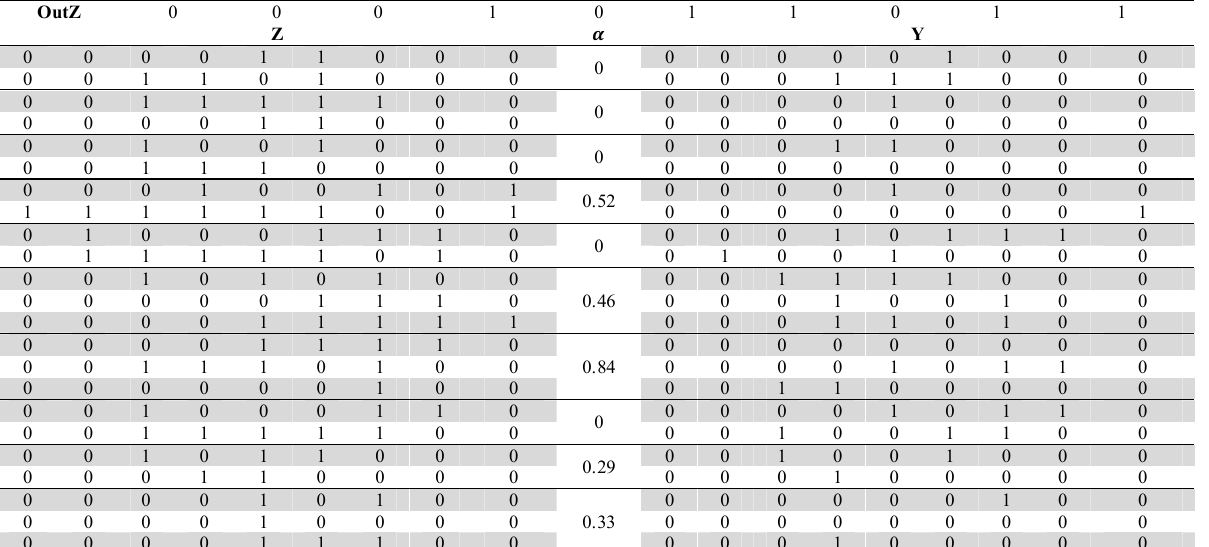
Sample representation matrix for coverage of exterior